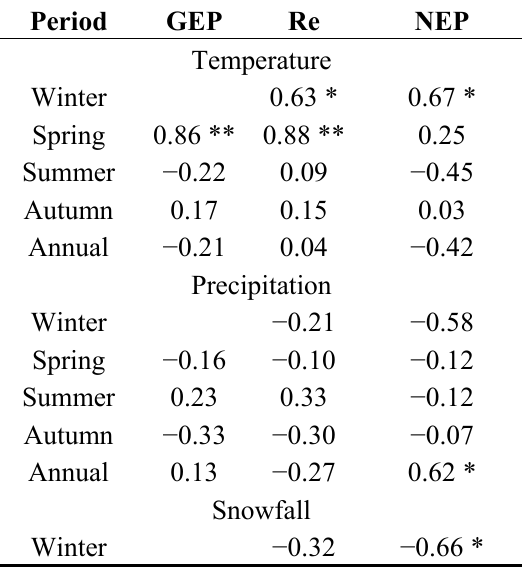
Table 2. Correlation of gross ecosystem productivity (GEP), ecosystem respiration (Re) and net ecosystem productivity (NEP) against seasonal and annual mean temperature and precipitation from 2003 to